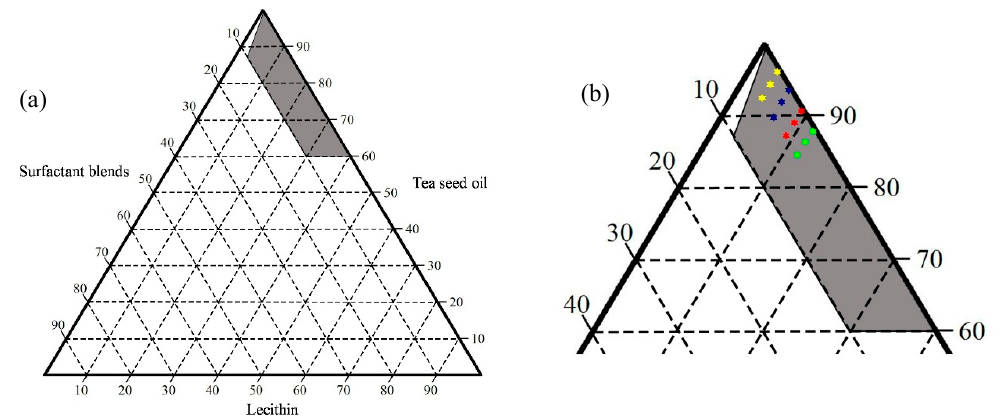
Figure 2. Ternary phase diagram showing the region of clear isotropic liquids (grey) for SEOF; normal scale ( a ) and close-up view of the isotropic region ( b ).